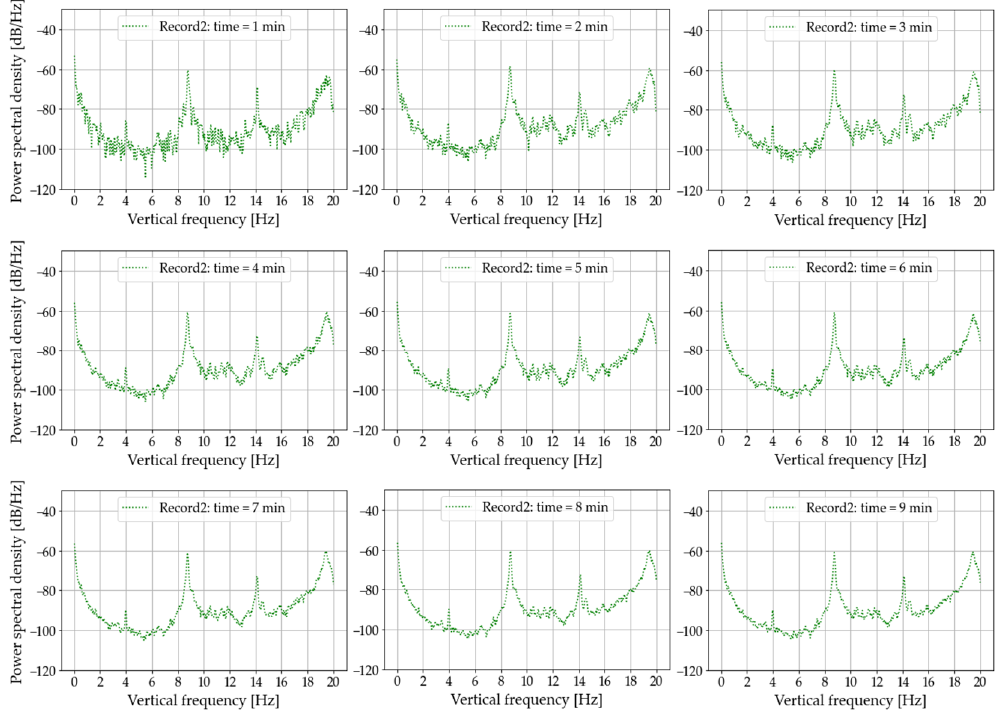
Figure 19. Power spectral density of the last nine vertical frequency observations of the Unilibre bridge.